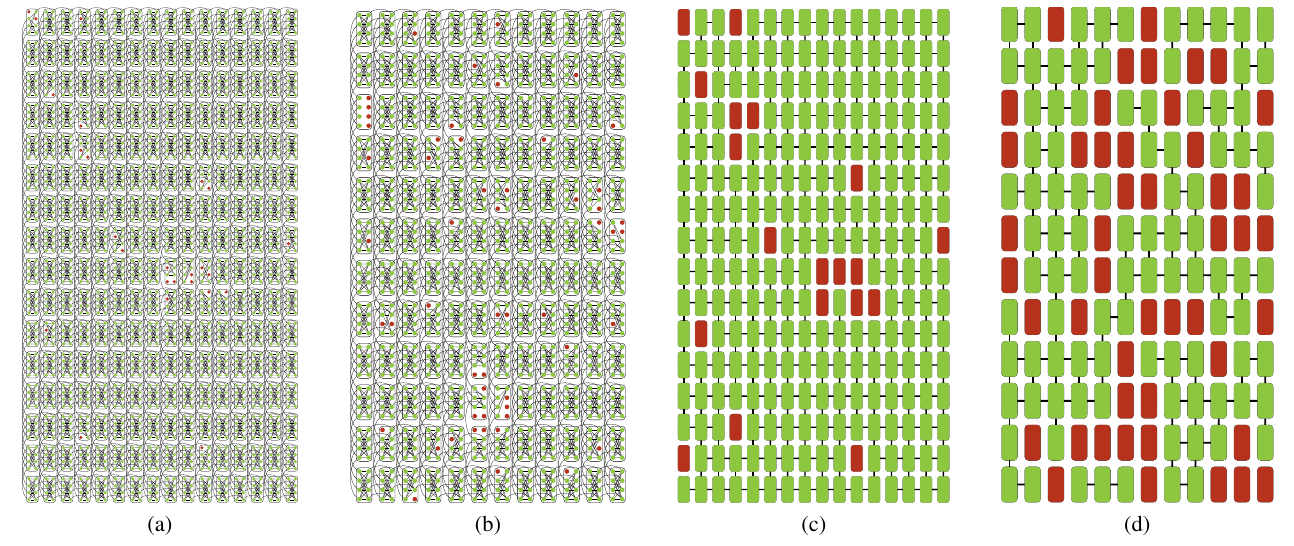
FIG. 10. Hardware and logical graphs for instance generation. (a) DW2KQ hardware graph, (b) DW2X hardware graph, (c) DW2KQ logical graph, (d) DW2X logical graph. For DW2KQ (DW2X) subgraphs of size L ≤ 16 ( L ≤ 12 ) were chosen starting from the lower right-hand corner. (a),(b) Available qubits are shown in green, and unavailable qubits are shown in red. Programmable couplers are shown as black lines connecting qubits. (c),(d) Complete unit cells are shown in green, and incomplete ones are shown in red. Logical couplers are shown as black lines between the unit cells. The unit cells are numbered from 0, starting from the top left-hand corner and moving across rows to the